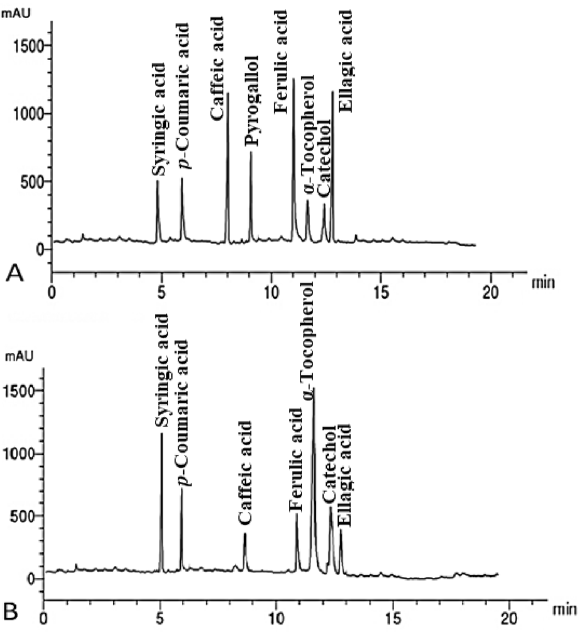
Figure 6. HPLC chromatograms of phenolic compounds identified in the methanolic leaf extracts of U. dioica ( A ) and D. viscosa ( B